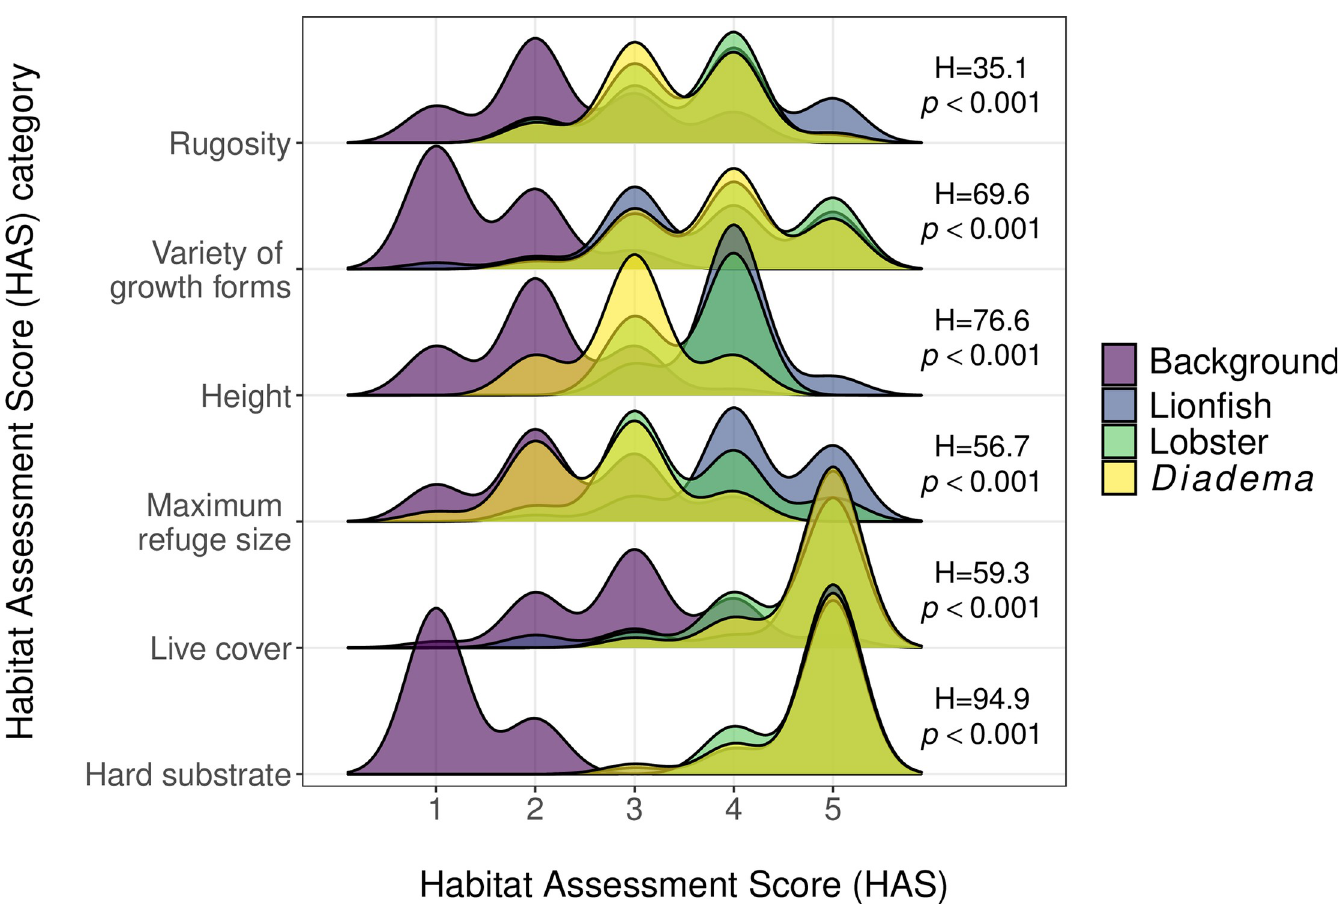
Fig 4. Habitat Assessment Score (HAS) joyplot. HAS are plotted for background ( n = 36), lionfish ( n = 35), lobster ( n = 28) and Diadema ( n = 22) quadrats. Larger HAS represents greater complexity. HAS are recorded on an ordinal scale from 1–5, thus it is the peaks in this joyplot that highlight the overlap, or lack of overlap, between the four groups. H-values and p -values represent the test statistic and significance of each Kruskal-Wallis test.